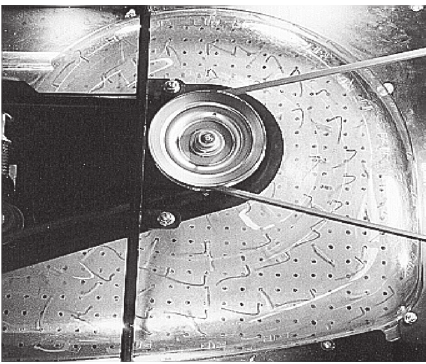
Figure 7: High-speed video test (tuft